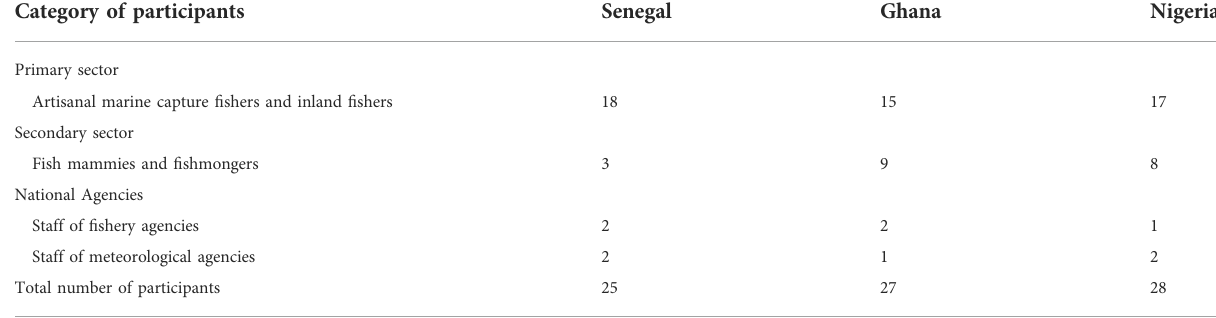
TABLE 1 Number and composition of participants across case